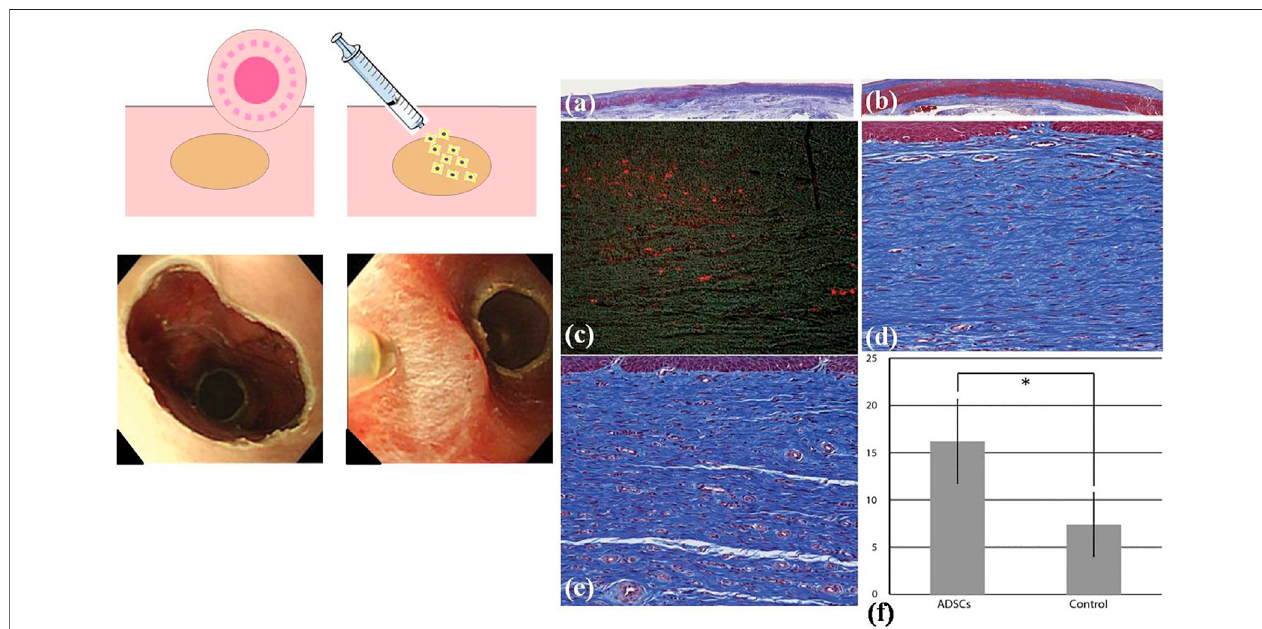
FIGURE 8 | Adipose tissue-derived stromal cellADSC) injection to prevent esophageal stricture. (A) The schematic diagram of cell injection. (B) The esophageal defect left after EMR and ADSCs were injected into the submucosa of the esophagus. (C) The pathological analysis of the esophagus. [C (i)] The esophageal mucosa tissue in the control group (Masson trichrome). [C (ii)] The esophageal mucosa tissue in the ADSC-treated group. [C (iii)] Stain-labelled ADSCs (red color) in the submucosa of the esophagus in the cell injection group. [C (iv)] Submucosal layer of the esophagus in the control group. [C (v)] Submucosal layer of the esophagus in the ADSC-treated group. [C (vi)] The comparison of the number of microvessels in esophageal submucosa between the control group and the ADSC- injected group. Reproduced from Honda et al. (2011). Copyright (2011), with permission from